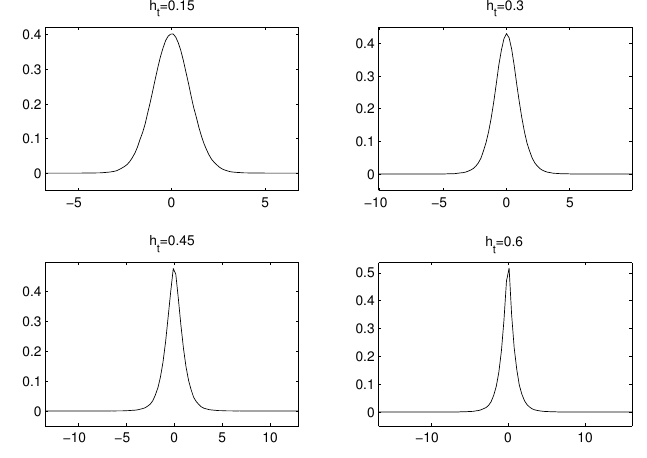
Figure 2. Densities for the simulated distributions (no volatility